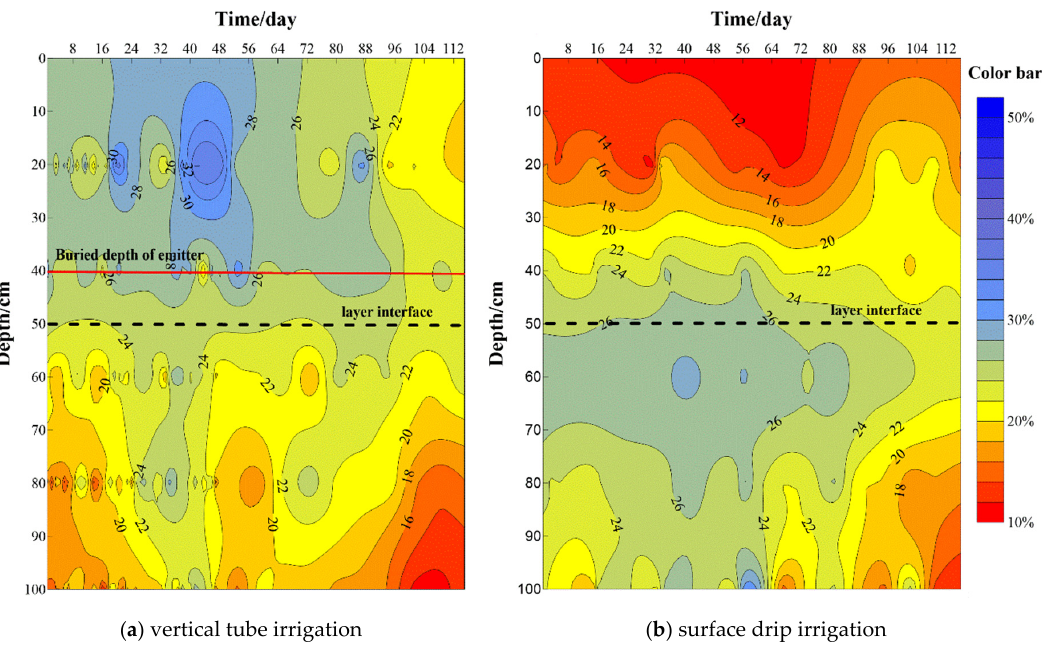
Figure 4. Vertical distribution of soil moisture content.